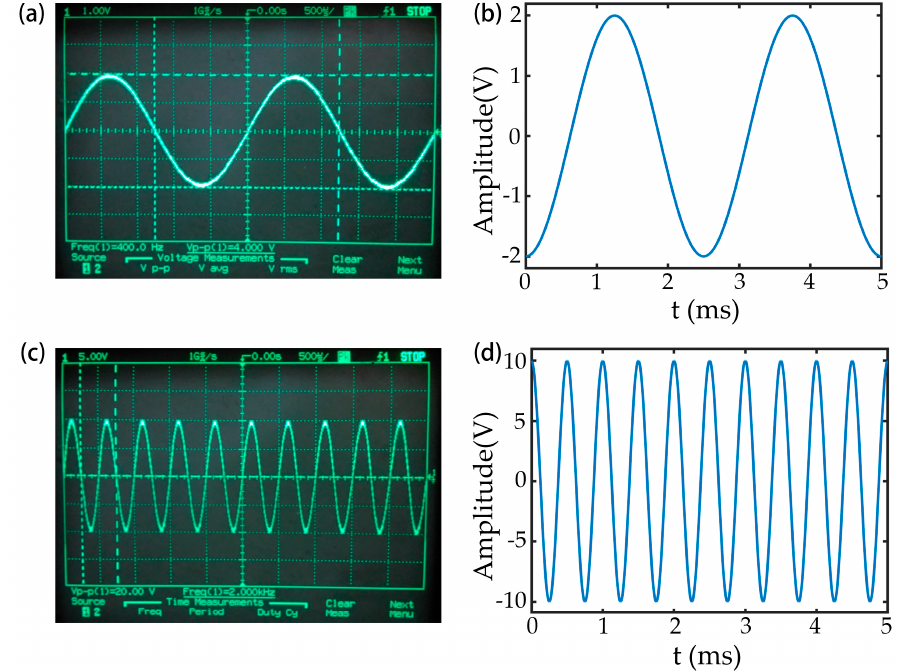
Figure 2. Oscilloscope waveforms of the input signal and the digital waveform collected by the AD converter controlled by the DSP: ( a ) Oscilloscope waveform with an input frequency of 400 Hz and a peak-to-peak value of 4.0 V; ( b ) waveform corresponding to Figure 2a acquired by the ADC; ( c ) oscilloscope waveform with an input frequency of 2 kHz and a peak-to-peak value of 20.0 V; ( d ) waveform corresponding to Figure 2c acquired by the ADC.